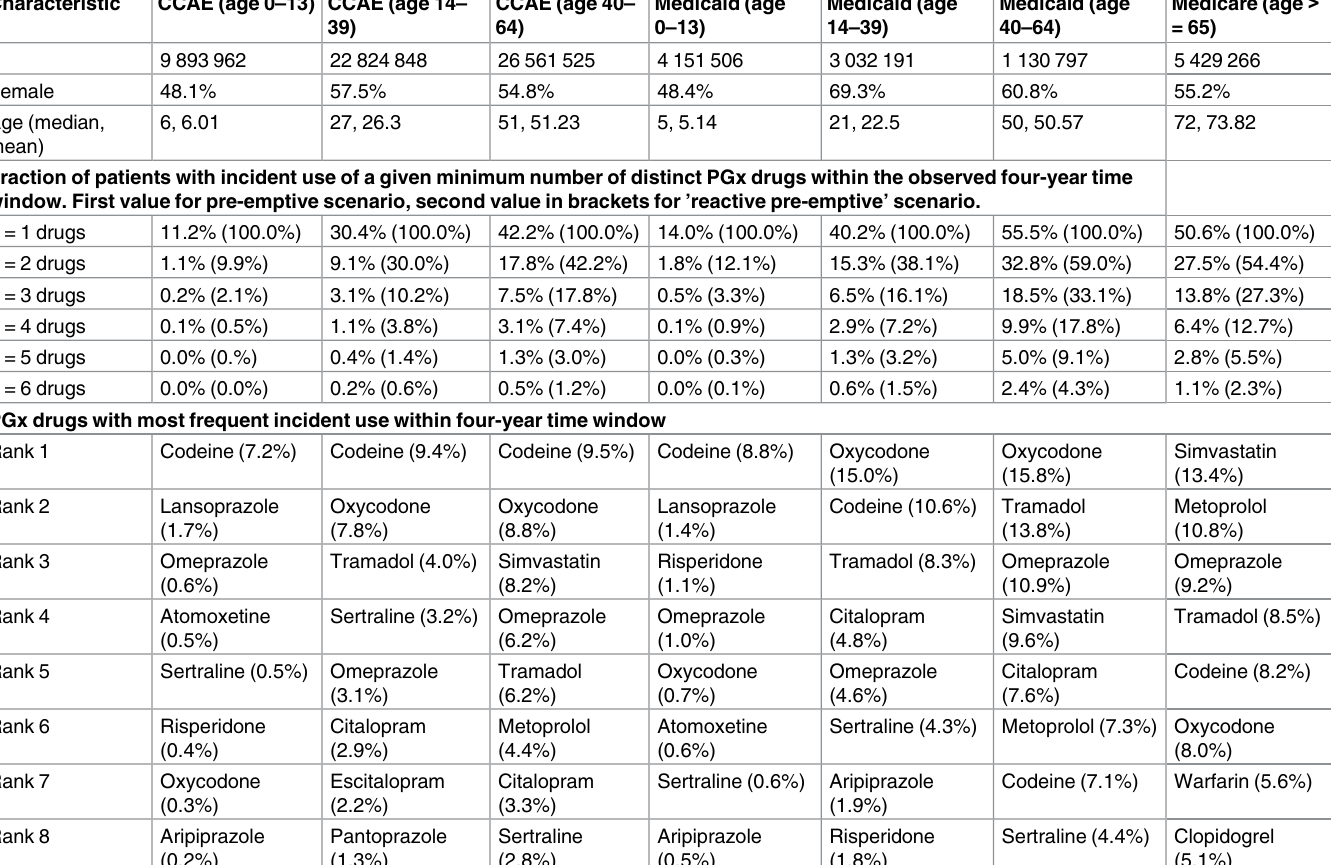
Table 4. Incidence of exposure to drugs for which pre-emptive pharmacogenomic testing is available.